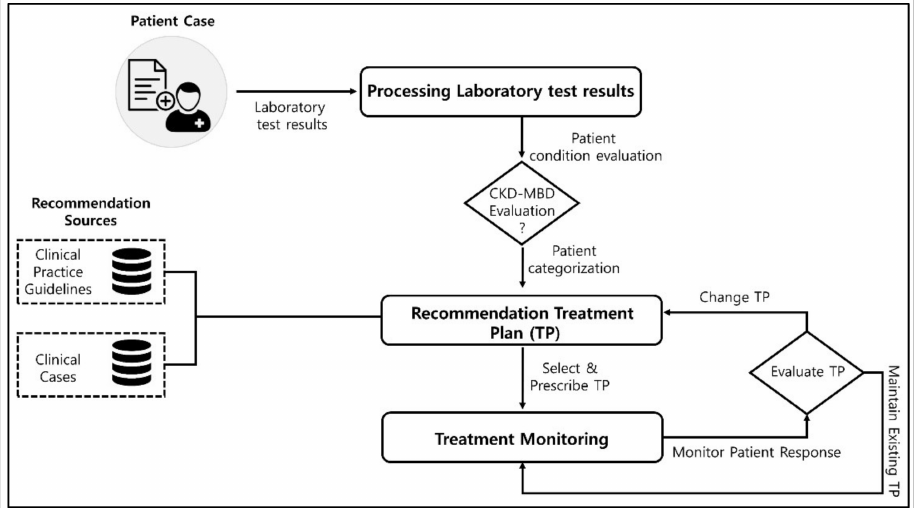
Figure 1. A generic process flow for the chronic kidney disease–mineral and bone disorder (CKD– MBD) treatment regimen